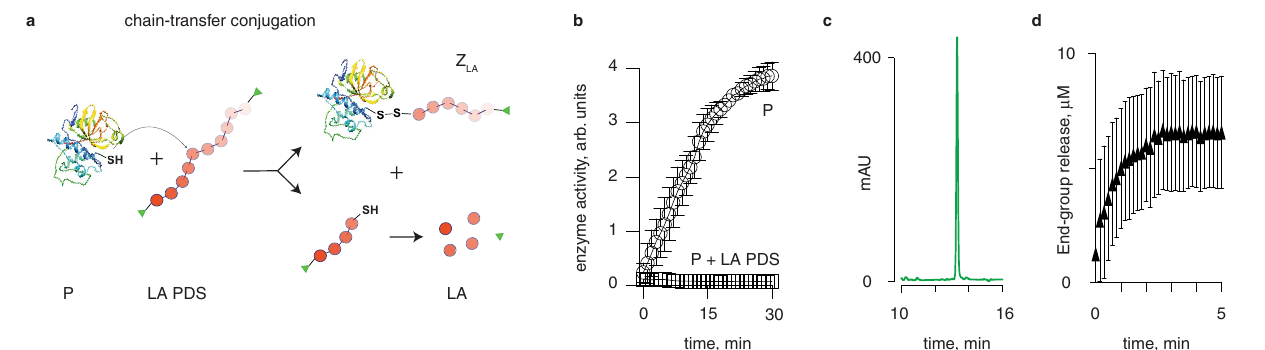
Fig.5|Chain-transferconjugationreactionbetweenthepolydisul fi depolymer andpapain.a SchematicillustrationofthereactionbetweenLAPDSandaprotein; b enzymatic activity of papain before and after reaction with LA PDS, c quanti fi cation of lipoic acid released during conjugation of LA PDS to papain via